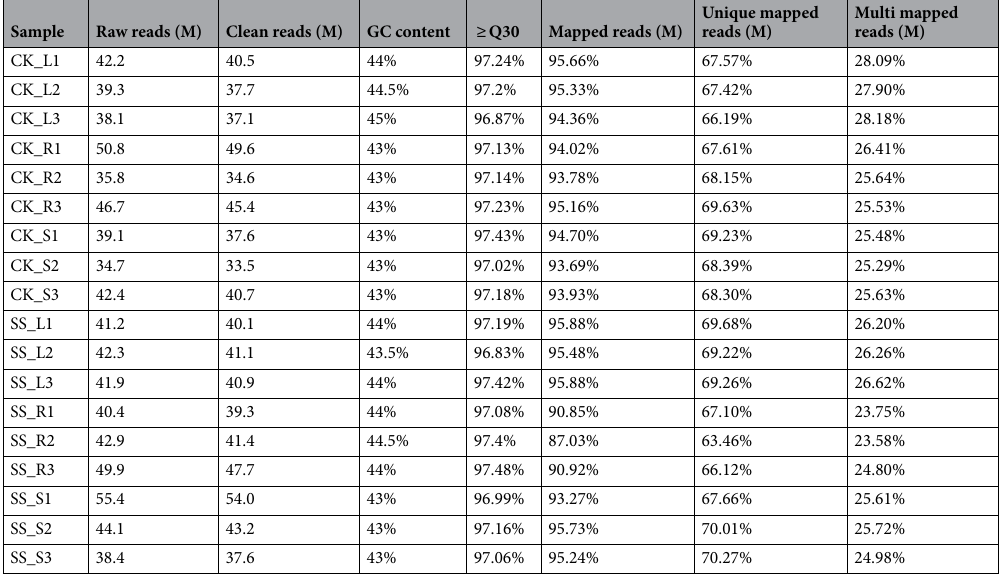
Table 1. Summary of the DGE sequencing tags and their matches in the G. hirsutum genome.